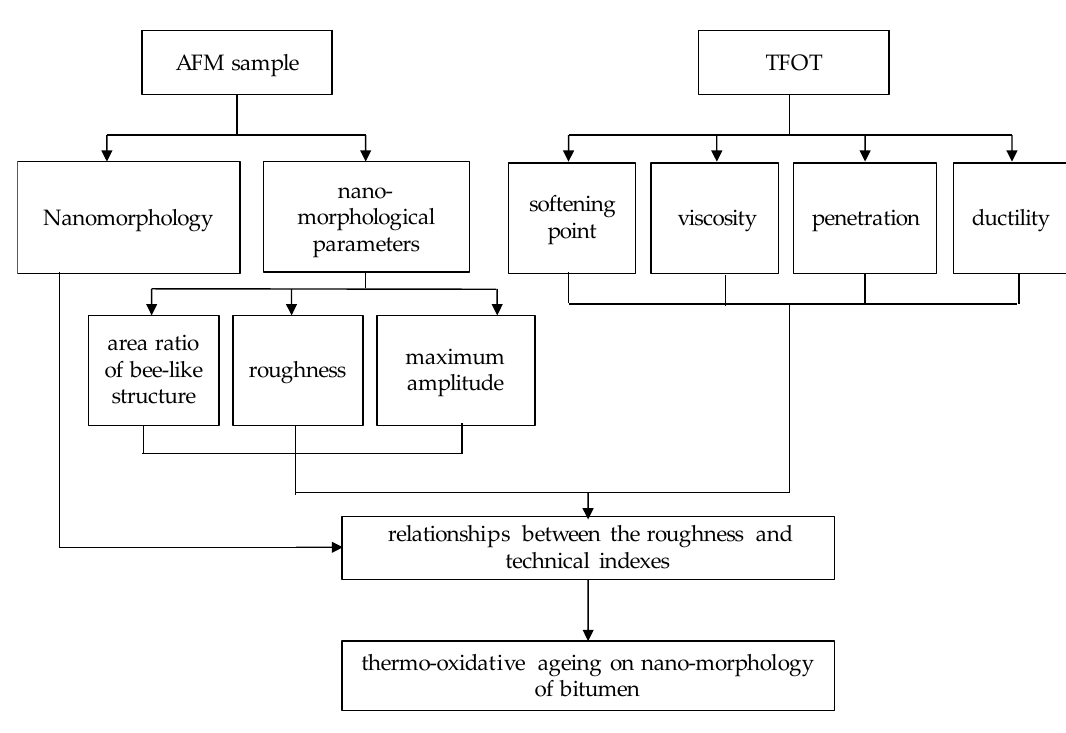
Figure 1. Technology roadmap of this paper.